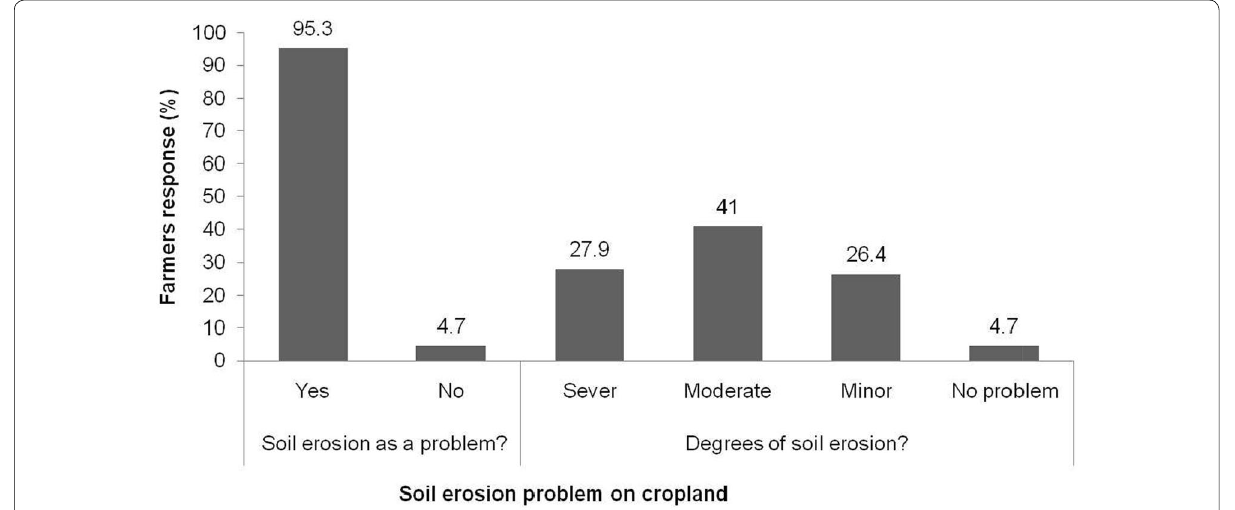
Fig. 3 Summery on farmers’ perception of soil erosion problems on their